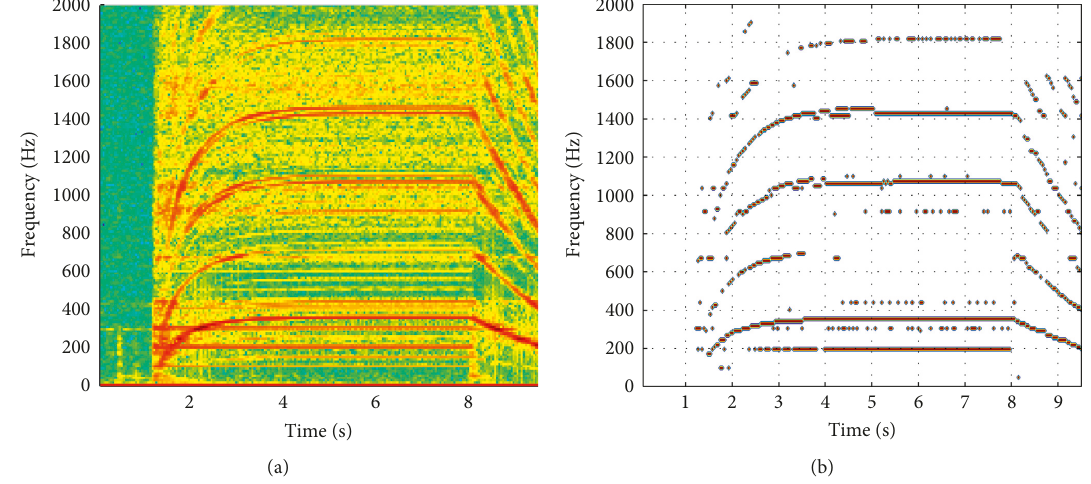
Figure 9: The spectrogram (a) with suitable peaks diagram (b) of the bed frame acceleration, for the third case.